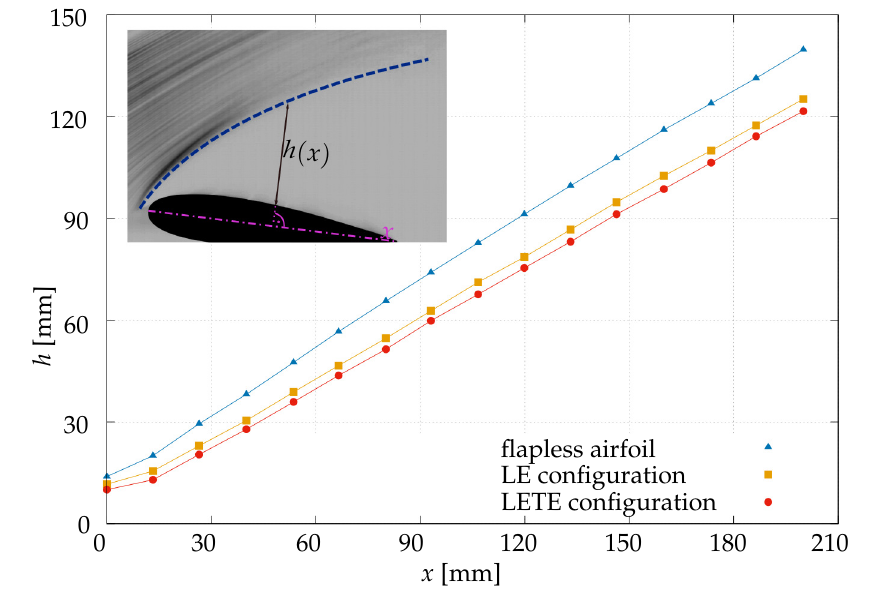
Figure 12. Distance h of the averaged separation line from the airfoil surface at position x on the chord line; separation lines of the flapless airfoil, LE, and LETE configurations are plotted for α =